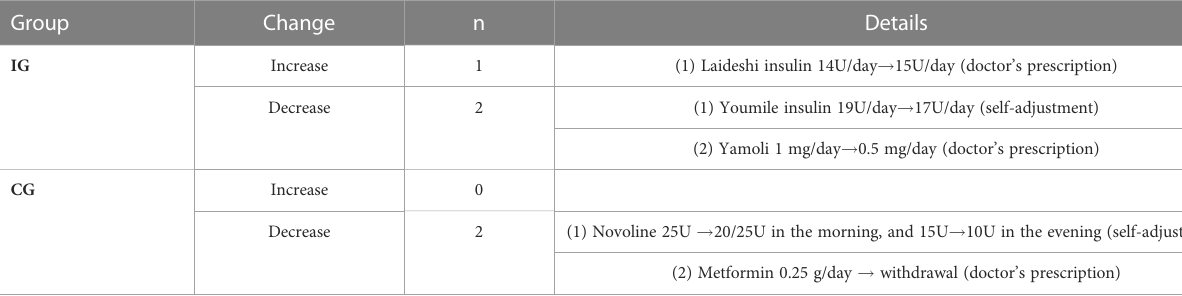
TABLE 8 Changes in medication during the intervention.